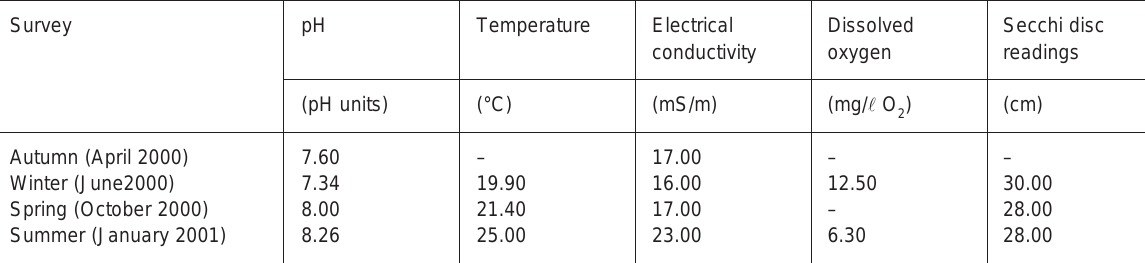
TABLE 1 Summary of water quality variables recorded seasonally at the Vaal Dam